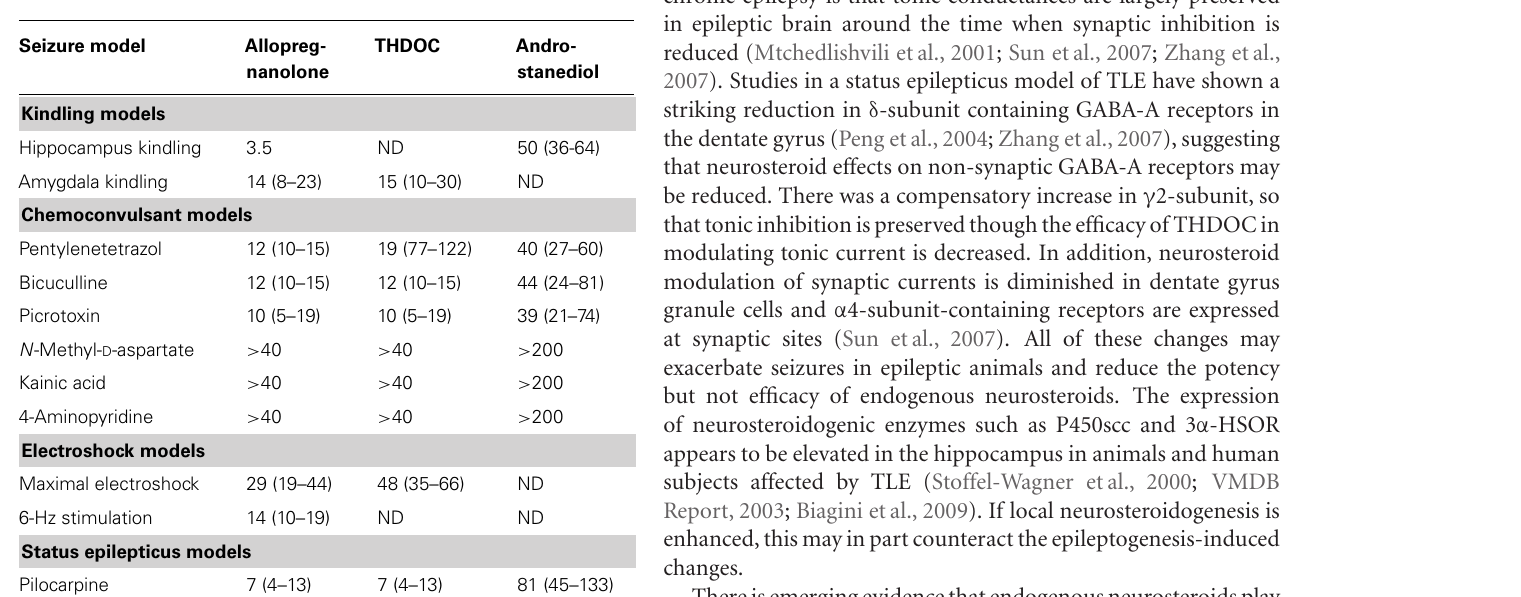
Table 4 | Pharmacological profile of major neurosteroids in animal